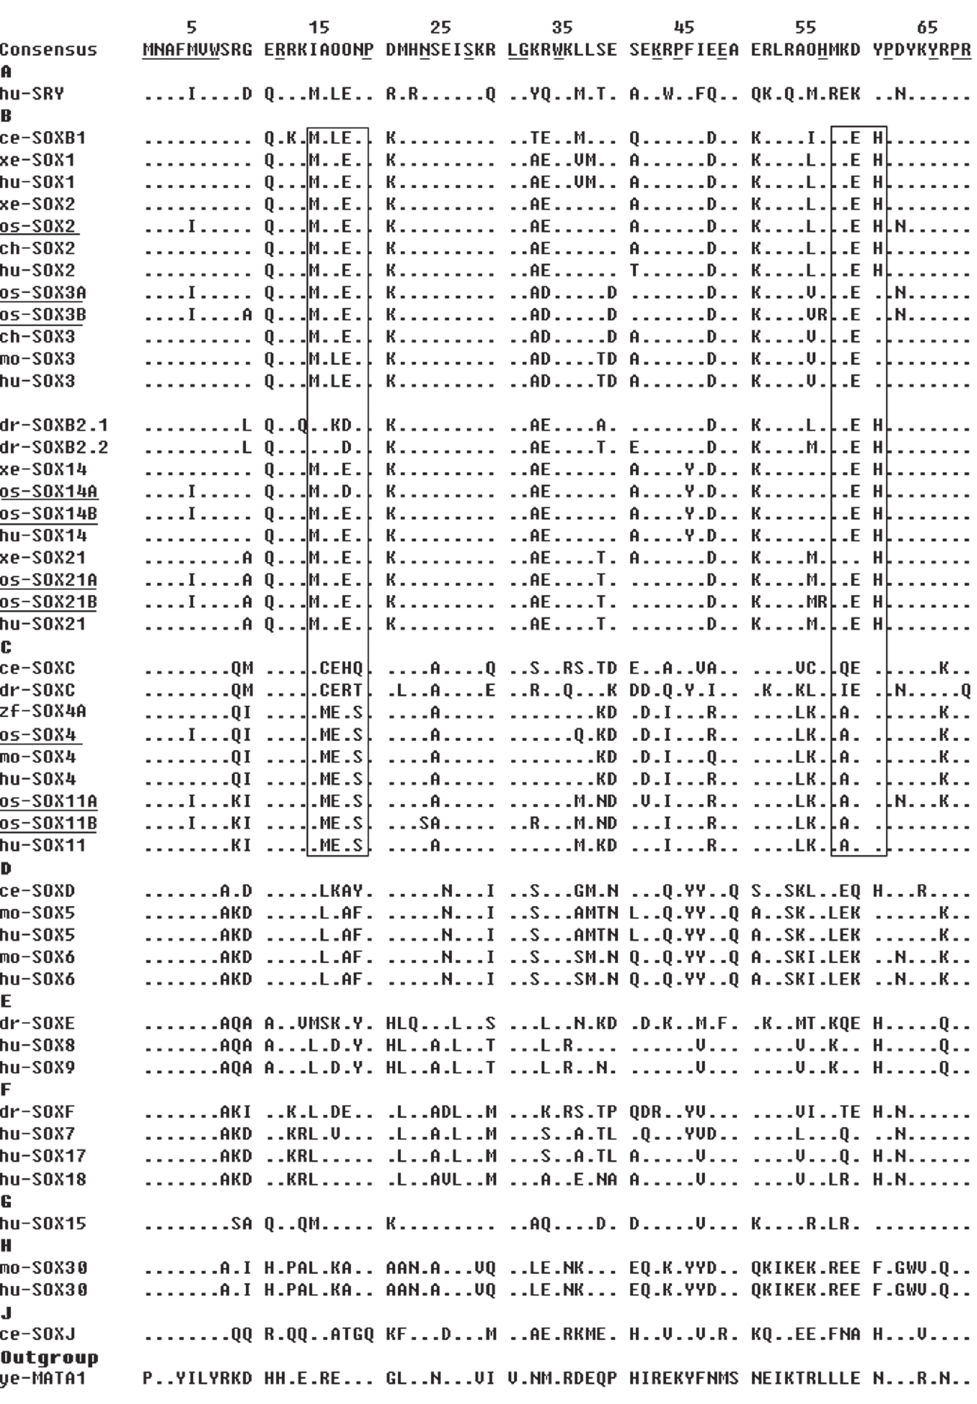
Figure 3. Alignment of the HMG domain of the Sox /SOX genes at amino acid level. Sequences are arranged into groups as defined by B OWLES et al. (2000). The consensus sequence was cited from B OWLES et al. (2000) too. Amino acid residues identical to the consensus sequence are indicated by a dash. Residues highly conserved are lined under the consensus sequence. The SOXs obtained from O. schmackeri are lined below. The characteristic sequences of group B and C are